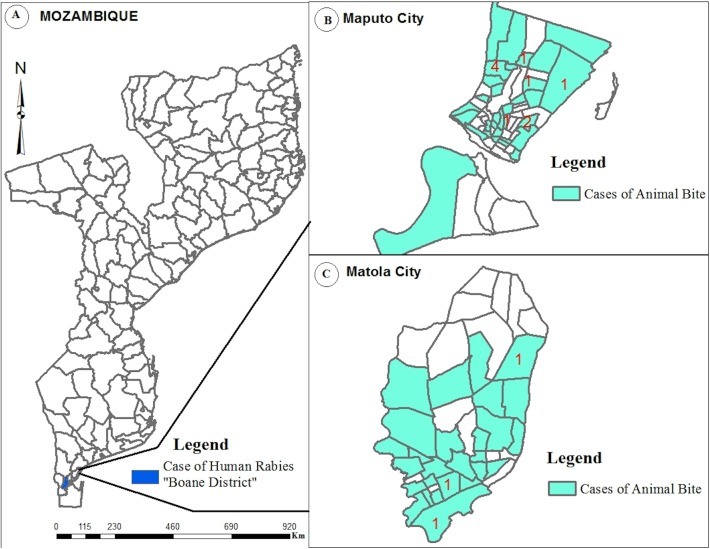
Geographical distribution of cases of animal bites and human rabies in Maputo and Matola cities between April and July 2014.Panel A depicts the Mozambique map and the study place is highlighted in blue color. Panel B shows Maputo city in higher magnification. Panel C shows Maputo province in higher magnification. In panel B and C, red numbers represent neighborhoods where cases of human rabies occurred and green color highlight neighborhood where dog bites were reported.